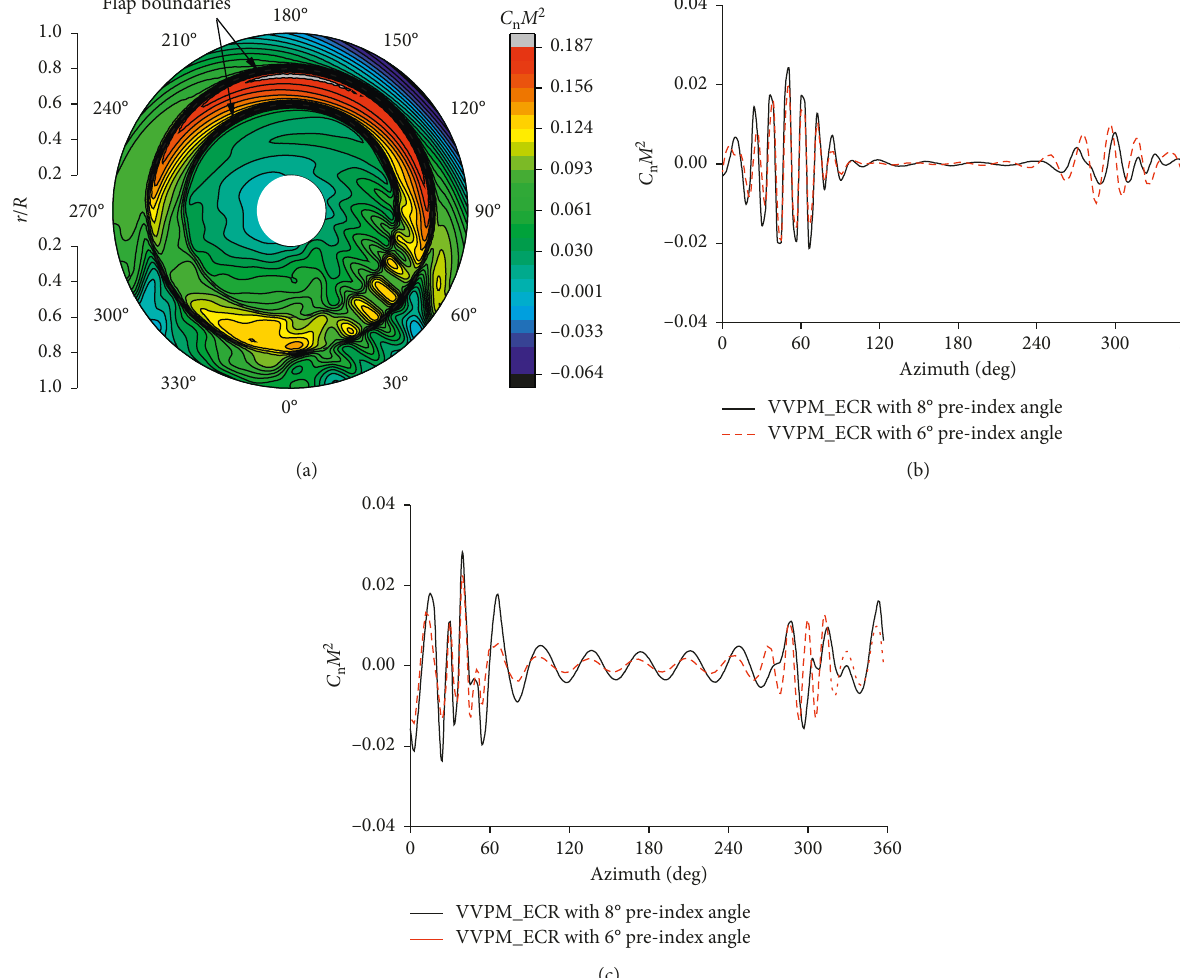
Figure 9: BVI airloads of ECR with 4 ° pre-index angle. (a) Disc airloads distribution; (b) high-frequency ( > 10/rev) section normal force M 2 at 70% span location; (c) high-frequency ( > 10/rev) section normal force C C n Flap boundaries